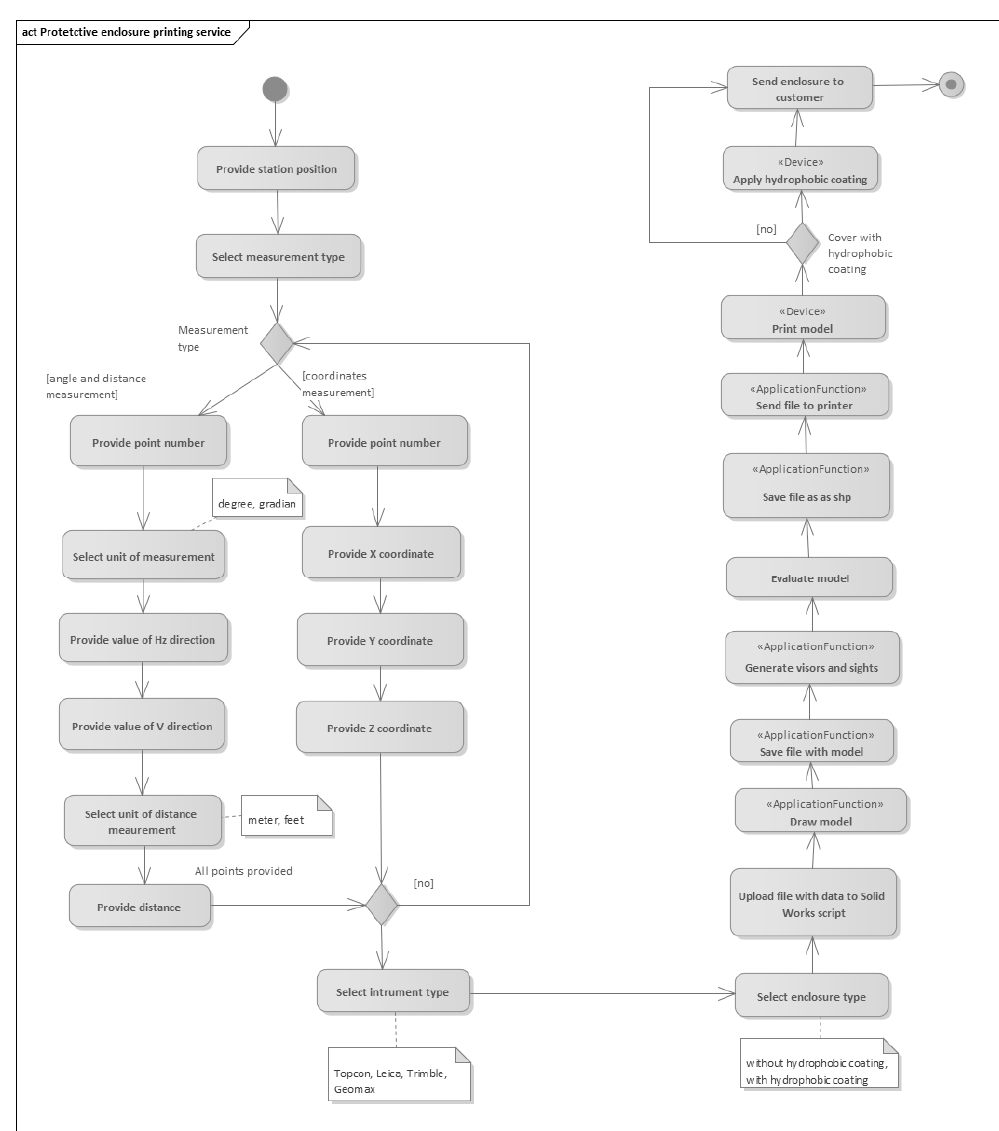
Figure 7. UML diagram formalizing the initial manufacturing process.